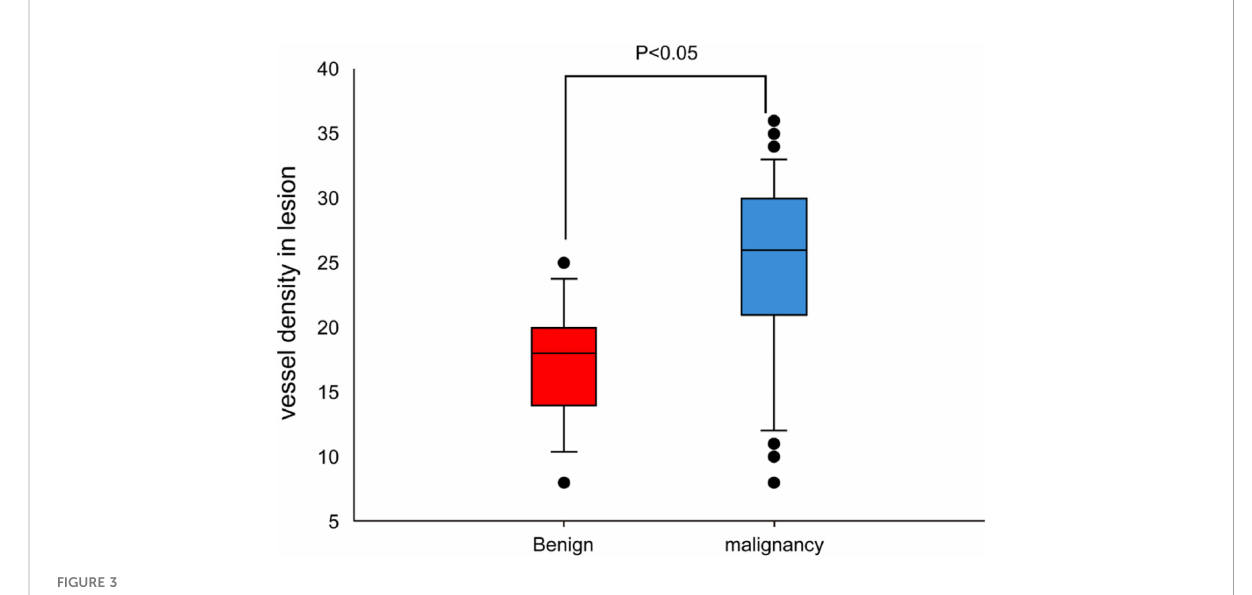
FIGURE 3 Comparison of MVD value between benign and malignant lesions.